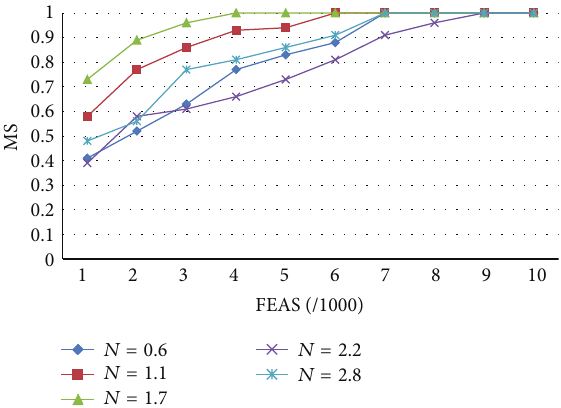
Figure 4: Comparison of 𝑁 of different disturbance mechanisms.